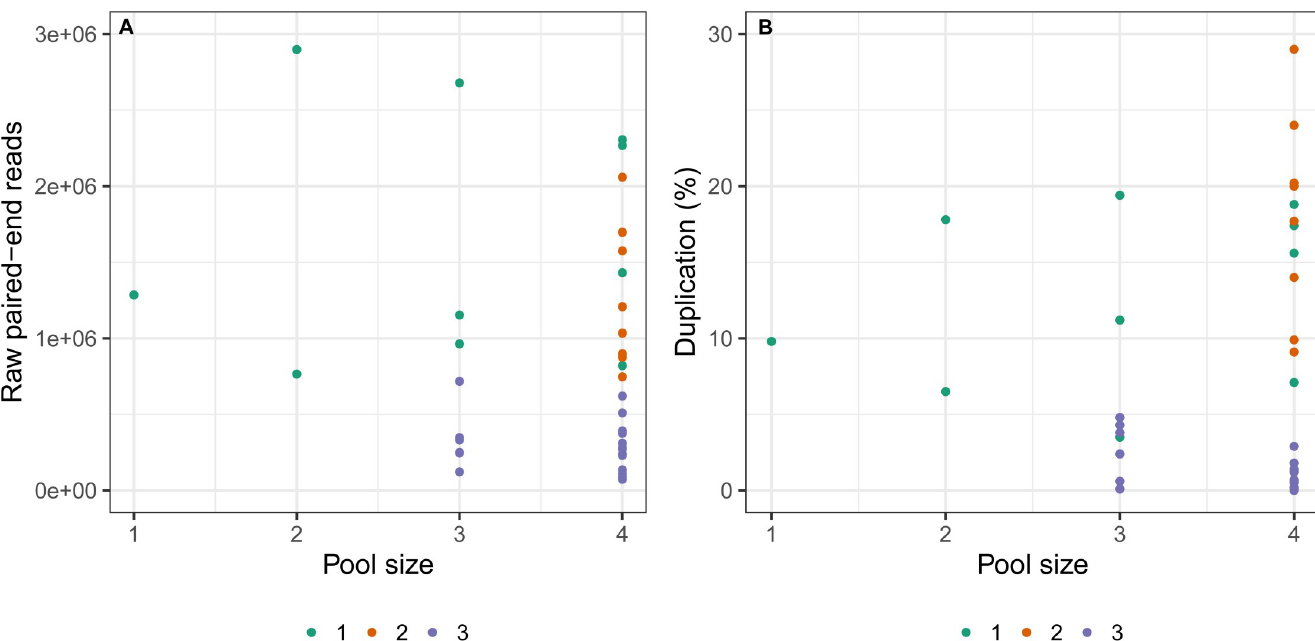
Fig 3. Plots of pooling sizes (1–4) prior to capture experiments against (A) raw paired-end reads and (B) duplication levels (%). Points are colour-coded by sequencing run, with run 1 indicated in green, run 2 in orange, and run 3 in